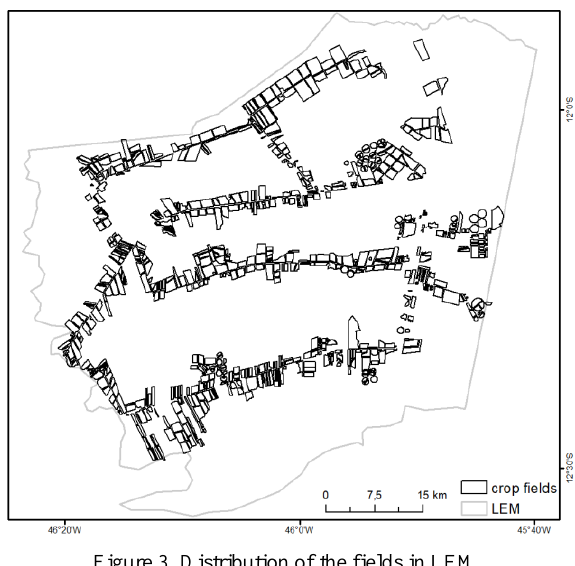
Figure 3. Distribution of the fields in LEM.